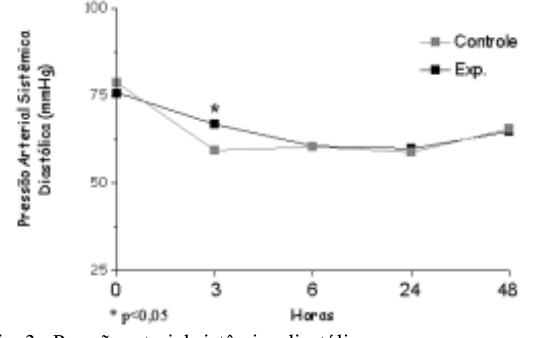
Fig. 3 - Pressão arterial sistêmica diastólica